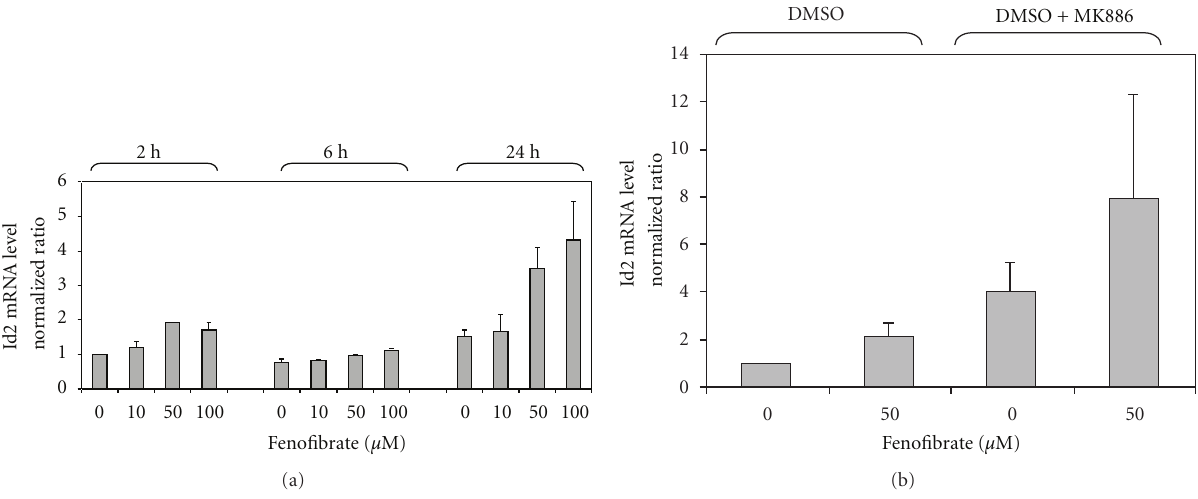
Figure 3: Fenofibrate upregulates Id2 gene expression in HepG2 cells. Panel (a) human hepatocarcinoma cells treated with di ff erent concentrations of fenofibrate (0, 10, 50, or 100 μ M) for 2, 6, or 24 hours. Relative Id2 mRNA levels were measured by real-time PCR, normalized to β -actin levels and expressed in relative units to control. Values for Id2 mRNA are expressed as mean ± SD ( n = 3). Panel (b) HepG2 cells were preincubated with the PPAR α antagonist MK-886 (10 μ M) where indicated and treated with di ff erent concentrations of fenofibrate (0 or 50 μ M) for 24